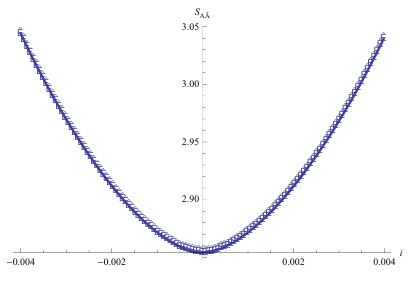
Figure 12 . The variation of S w.r.t. the parameter i corresponding to the bigger ansatz and A ~ A 1 ~ A 2 its shows that it is always greater than the corresponding value coming from the minimal